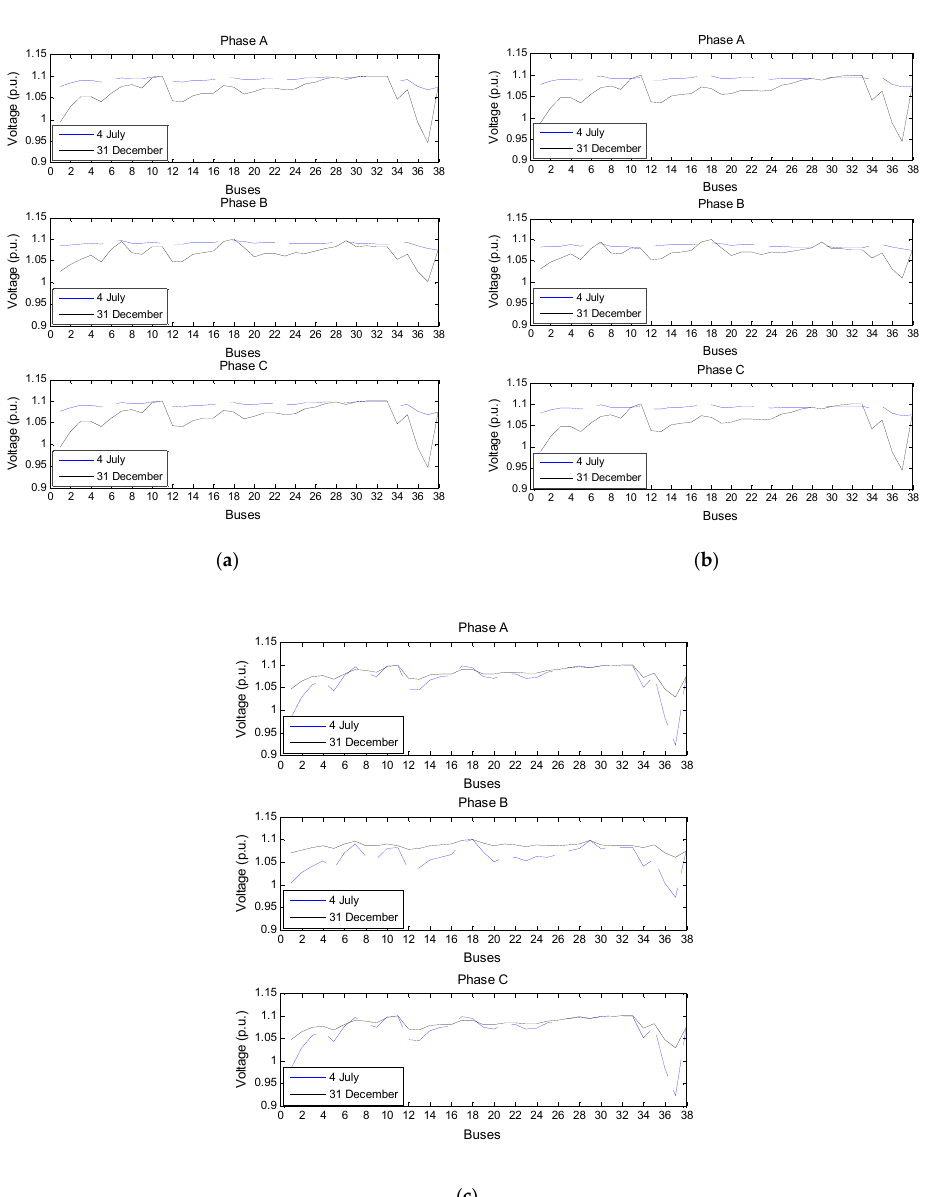
Figure 13. Voltage at 12 h for summer and winter days. ( a ) Low solar profile at the base load condition. ( b ) Low solar profile at an additional 40% load in all phases. ( c ) High solar profile at an additional 40% load in all phases.